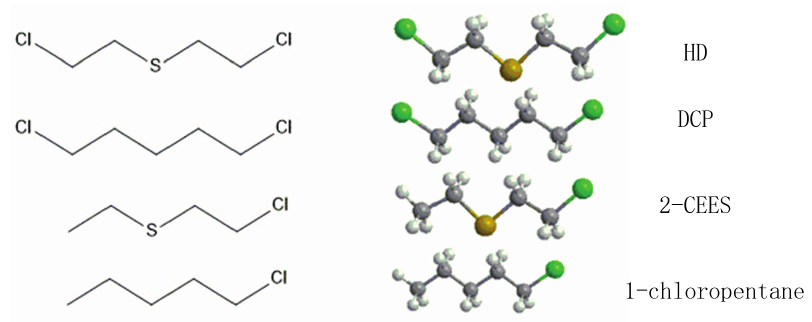
Figure 8. Molecular structures of HD, its simulants and 1-chloropentane.